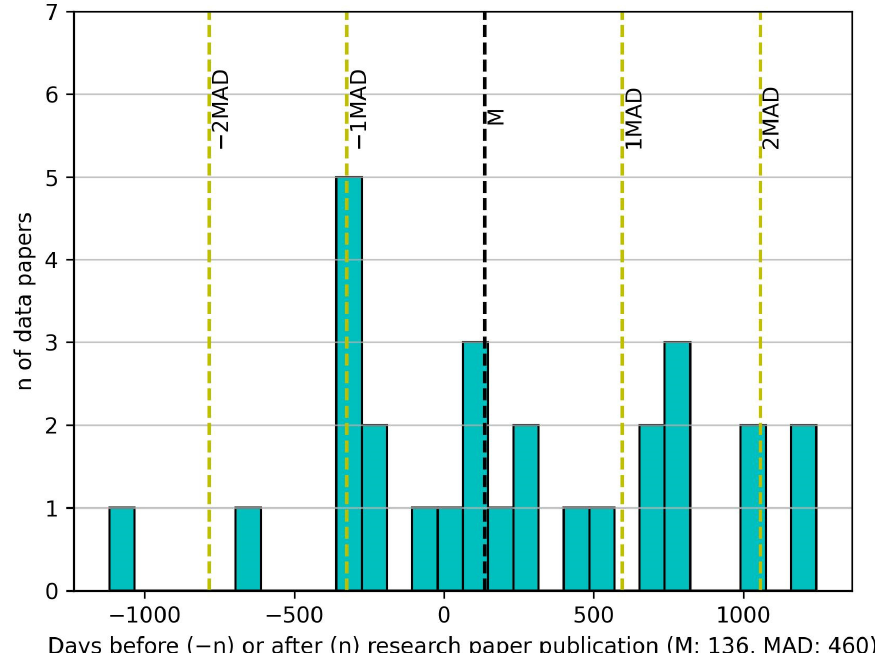
Figure 6. Number of days elapsed between the publication of a research paper and the publication of the associated data paper by JOHD or RDJ. 0 on the x -axis is the date of publication of a dataset, so that one data point at − 500 on the x -axis, for instance, indicates that one data paper was published 500 days before the publication of its associated research paper.